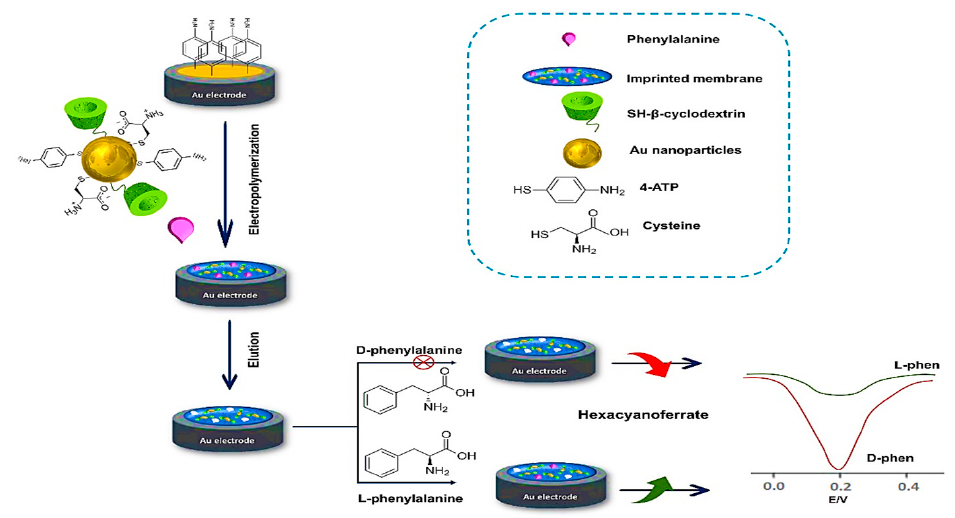
Figure 7. Fabrication procedure of the microporous MI-MOF-based enantioselective electrochemical sensor for recognizing L-phenylalanine enantiomers [78]. Redrawn by PowerPoint 365 soft- ware.